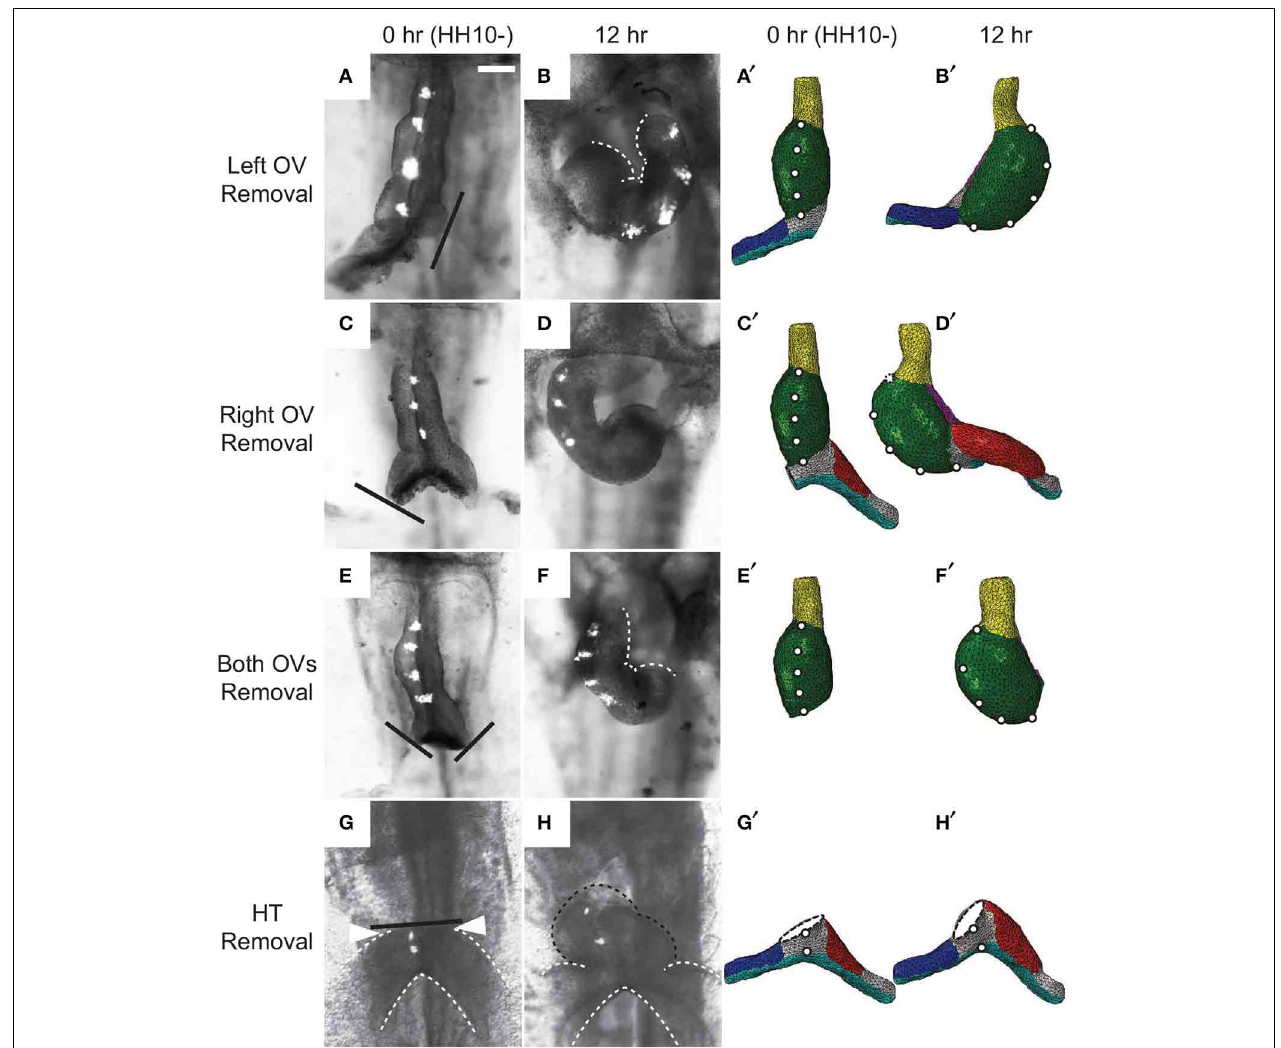
FIGURE 10 | Effects of removing omphalomesenteric veins (OVs) or heart tube (HT). (A–H) Bright-field images of experimental perturbations reprinted from Ramasubramanian et al. (2008) (A–F) and Kidokoro et al. (2008) (G,H) with permissions of ASME and Wiley. (A,C,E,G) HH10- hearts with (A) the left OV, (C) the right OV, (E) both OVs, or (G) the HT removed. For access to the heart, the splanchnopleure was removed first. Black lines denote the cuts. To help visualize rotation, fluorescent labels were injected along the ventral